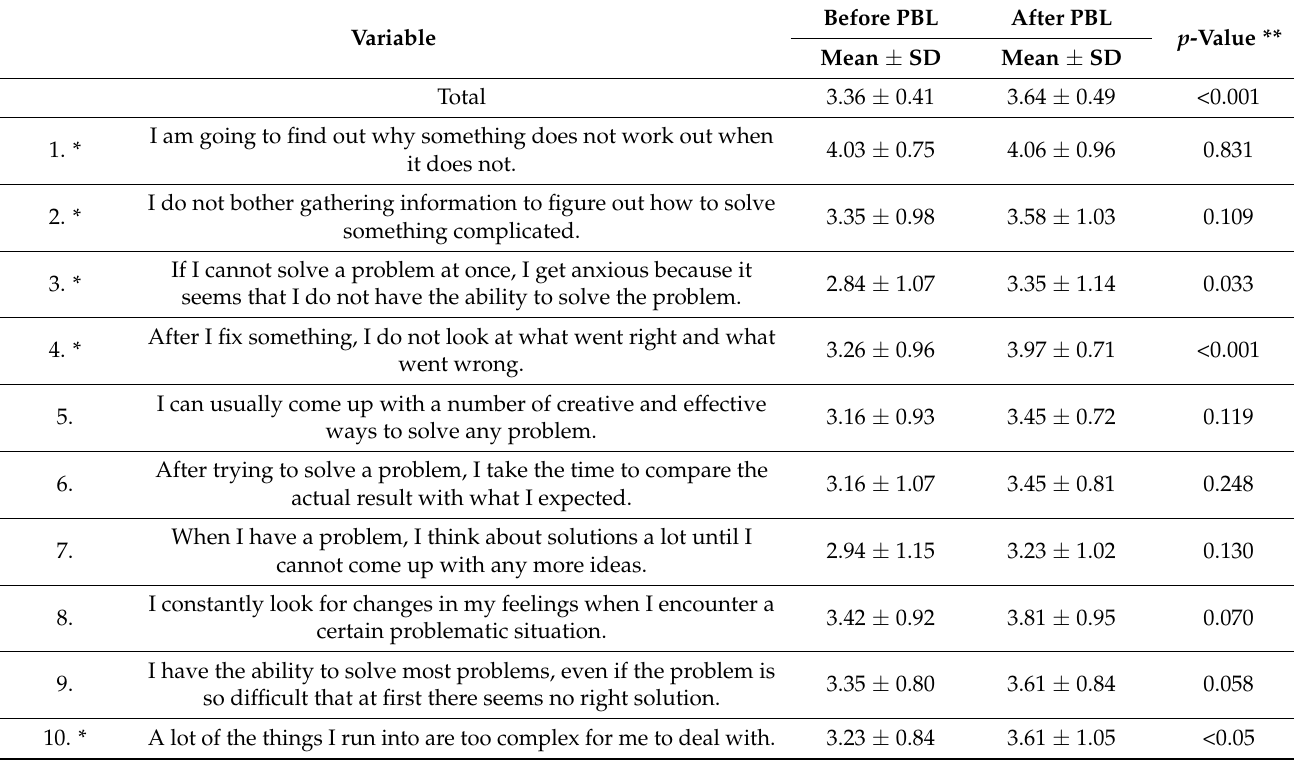
Table 1. Problem-solving ability of